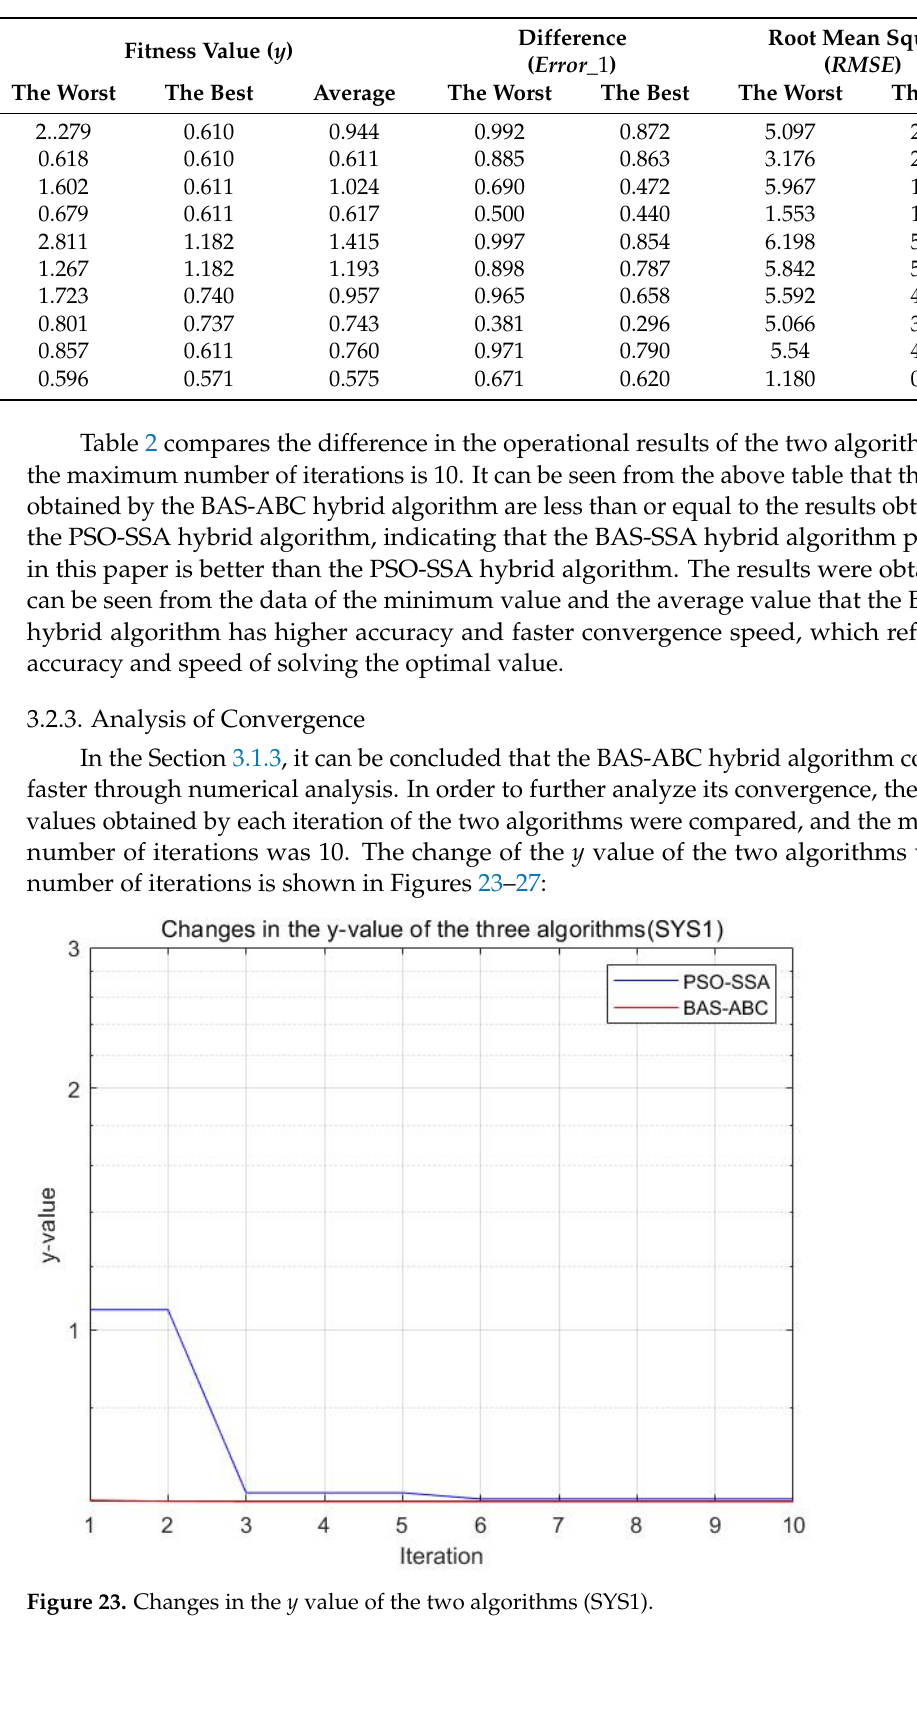
Figure 24. Changes in the 𝑦 value of the two algorithms (SS3).